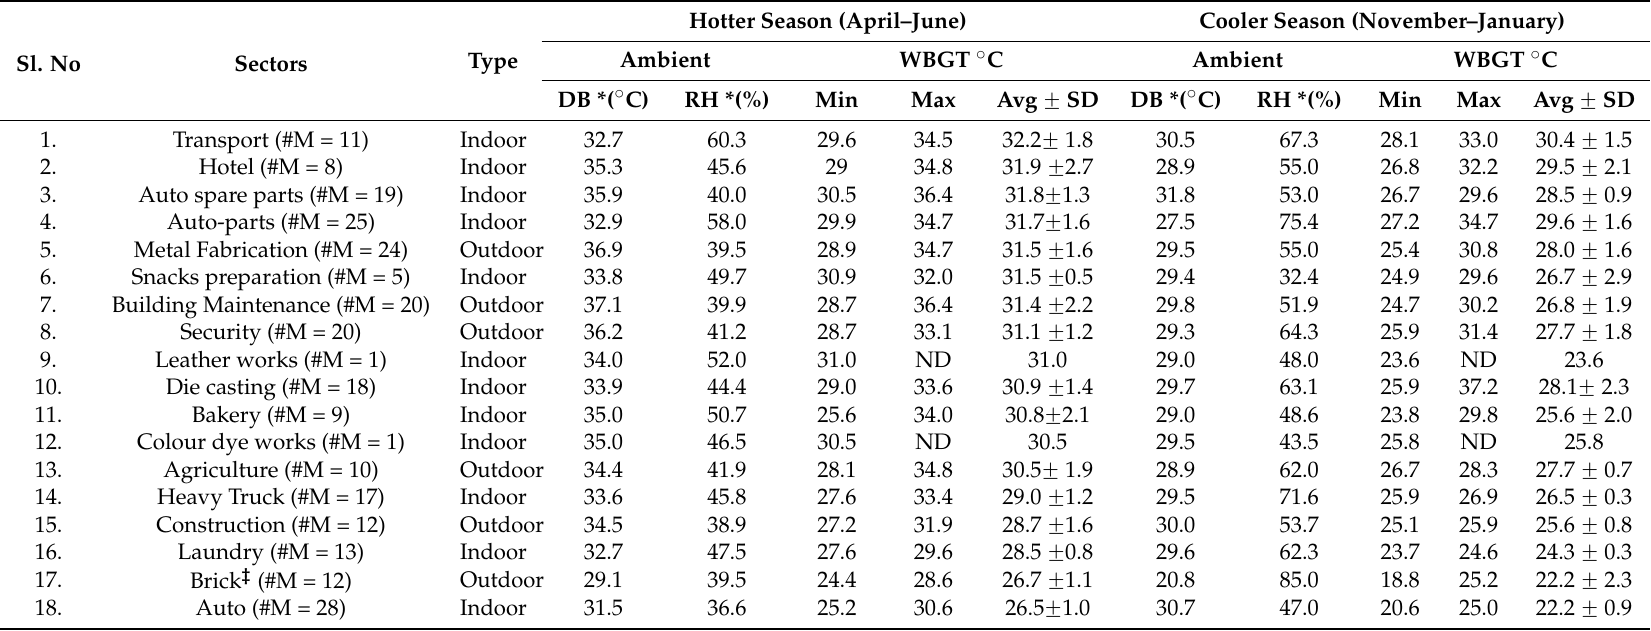
Table 1. Seasonal exposure profiles for occupational heat stress for different workplaces in India